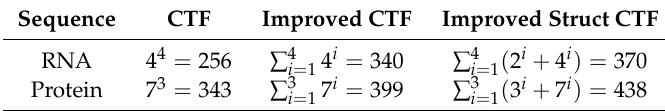
Table 5. The sequence coding lengths for protein and RNA of different encoding